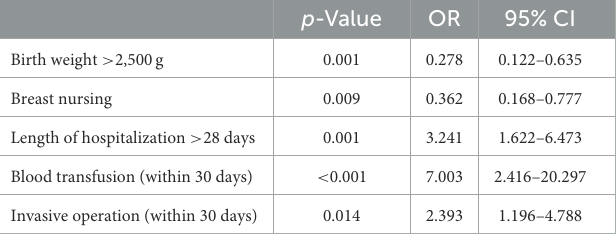
TABLE 3 Risk factors for carbapenem-resistant Pseudomonas aeruginosa infection with multivariate logistic regression analysis. p -Value OR 95%